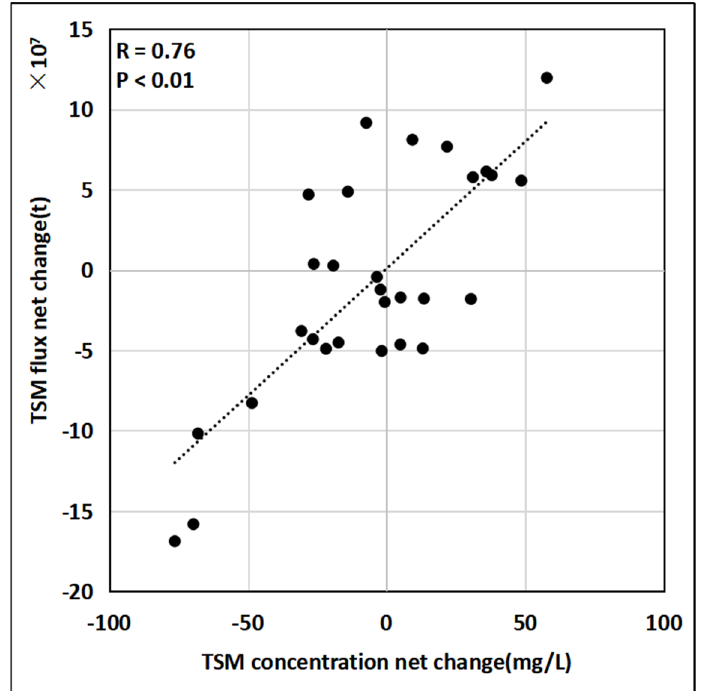
Figure 13. Correlation between the changes in C TSM and F TSM in the Padma River.